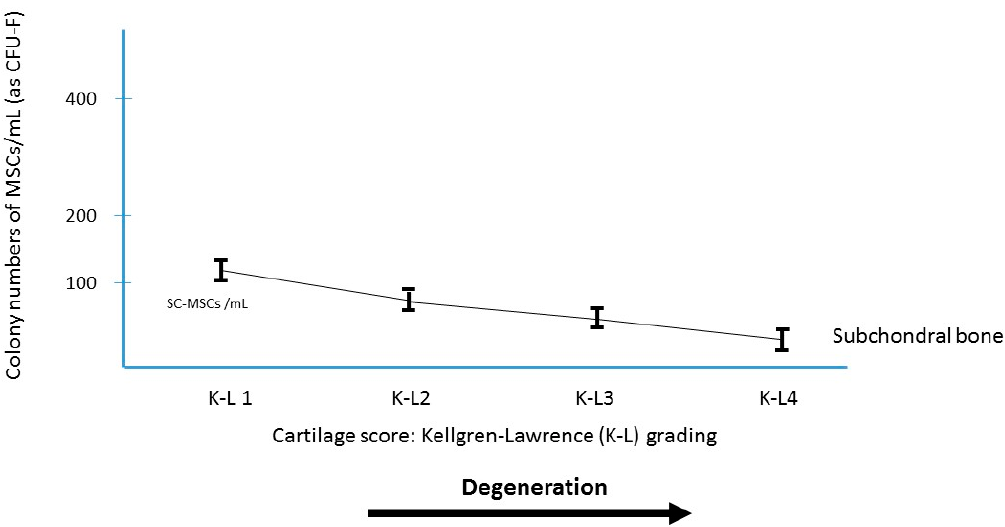
Figure 4. MSCs in subchondral bone derived from osteoarthritis patients. Relationship between the osteoarthritis grading and the colony number of subchondral bone marrow aspirate (mL).